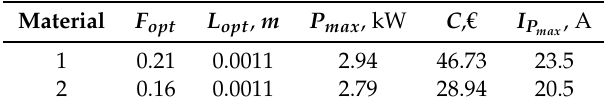
Table 7. TEG design parameters used for the case studies in Section 4. The power generation and cost are per combustion chamber.